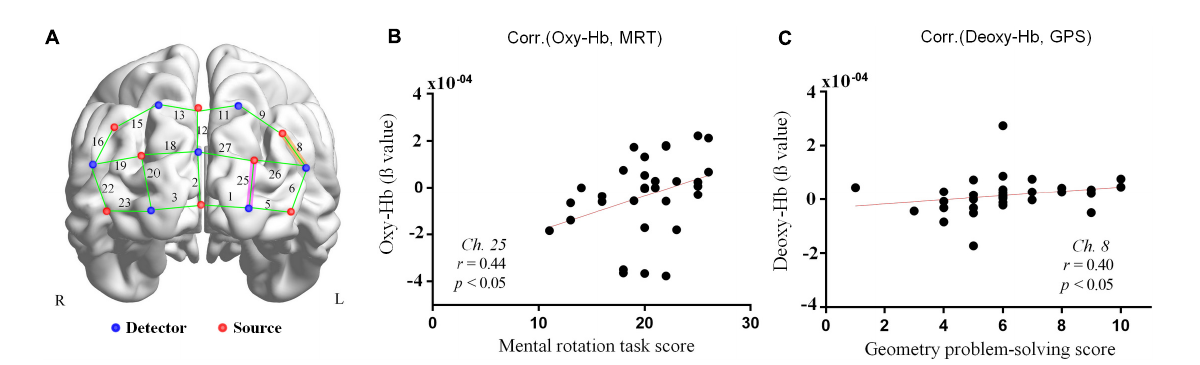
FIGURE5 Correlation graphs and fNIRS channels positions. (A) 3D-rendered brain template (ICBM152) with left (L) and right (R) hemispheres from BrainNet Viewer toolbox (Xia et al., 2013). The fNIRS channels are positioned across the cortex. The red points represent sources, the blue points are detectors, and the green lines are channels. The purple highlight indicates the channel associated with the correlation between oxy-Hb variation and mental rotation task (MRT). The orange highlight indicates the channel associated with the correlation between Deoxy-Hb variation and geometry problem-solving (GPS). (B) Scatter plots between the number of correct responses on MRT and oxy-Hb variation at channel 25 ( r = 0.43; p = 0.01). (C) Scatter plots between the number of correct responses on the geometry test and deoxy-hemoglobin (deoxy-Hb) variation at channel 8 ( r = 0.4; p = 0.02).